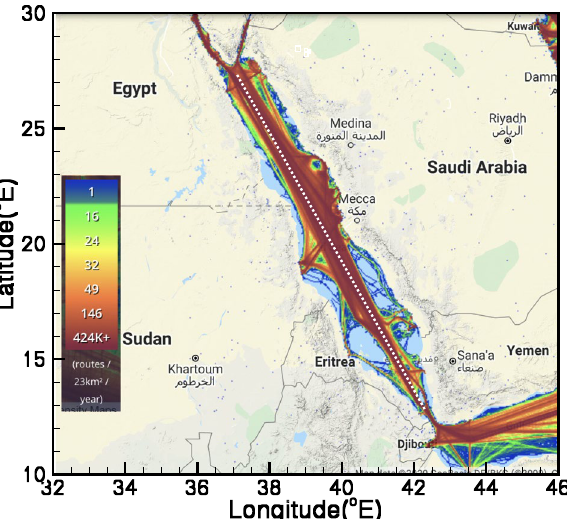
Figure 2. Contours depicting the marine traffic density and the release locations (shown in white dots along the longitudinal axis) in the Red Sea. The density is defined for the number as ships per 23 square kilometers averaged over a year (https:// www. marin etraffi c. com). The figure was created on Matlab-r2020b (https:// matlab- r2020b. softw are. infor mer.